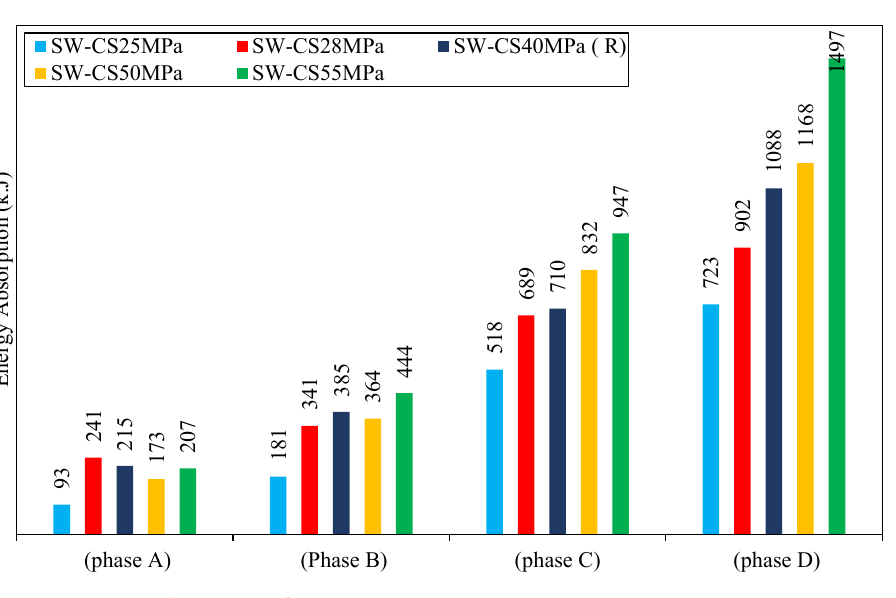
Figure 17. Energy absorption of group 2.